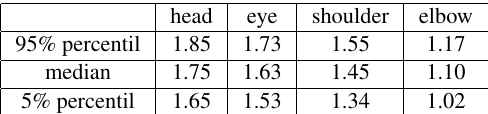
Table 3. Height to the ground plane for German men between 18-65 years. The Table is based on (DIN EN 33402-2, 2005).